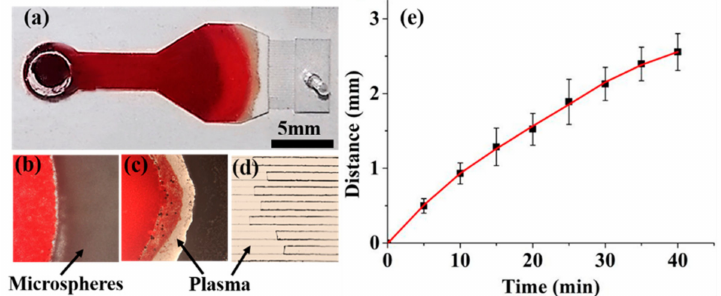
Figure 3. ( a ) Photo of the microchip during the plasma separation. Optical microscopy images of ( b ) the start separation of the plasma, ( c ) movement of the plasma within the microsphere barrier, and ( d ) flow of the plasma in the capillary microchannels. ( e ) The moving distance of the plasma as a function of